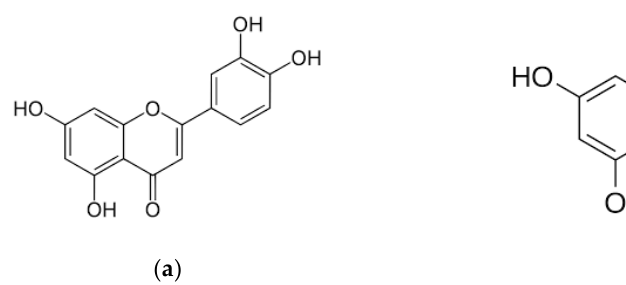
Figure 1. Chemical structures of ( a ) luteolin and ( b ) chrysin.